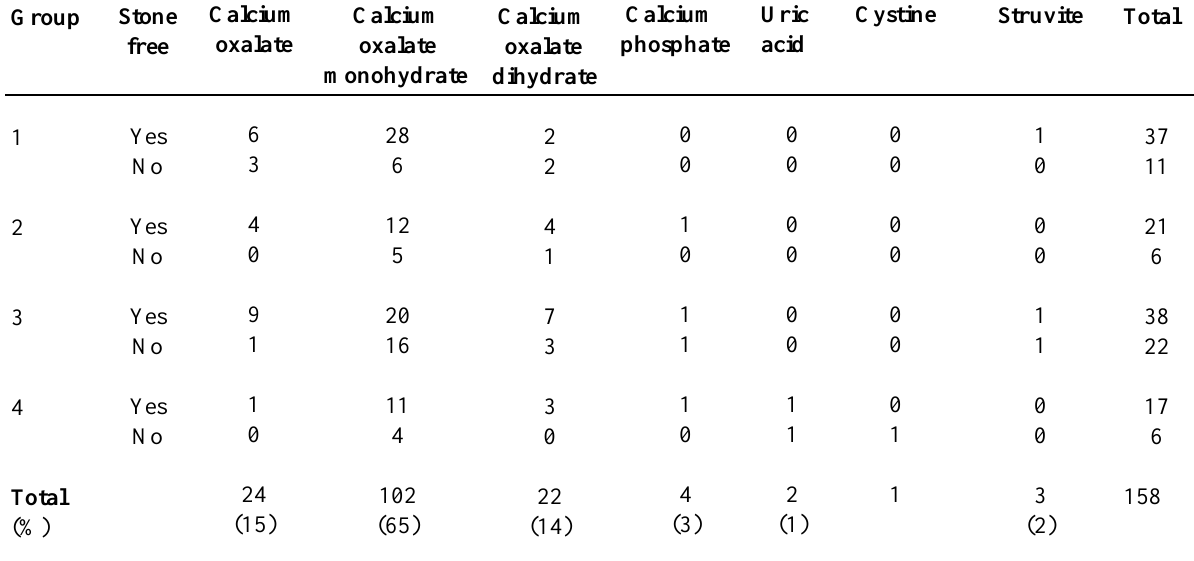
Table 2 – Stone composition of stone-free and non-stone-free patients. Values in table represent the number of patients with a particular major stone